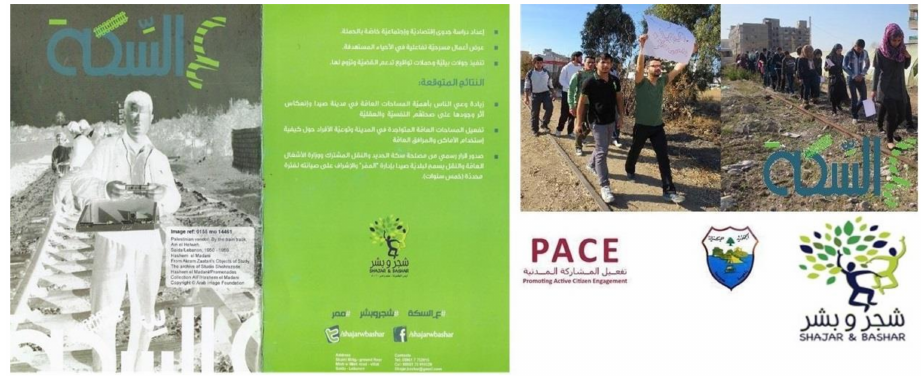
Figure 5. ‘Shajar w Bashar’ initiative building on the landscape concept of the USUDS landscape proposal for reviving the abandoned railway corridor as a city-scale, inclusive public